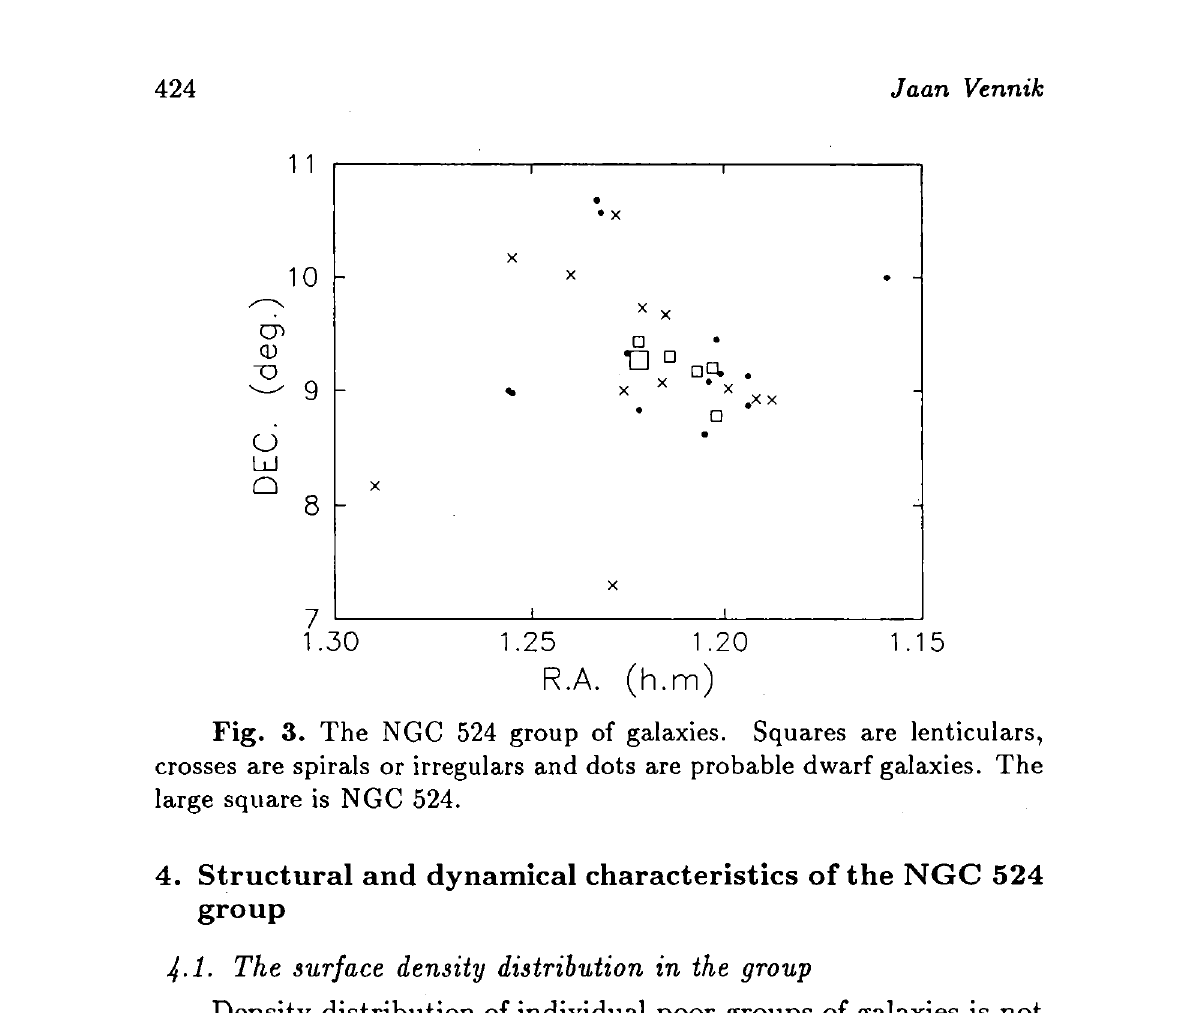
Fig. 3. The NGC 524 group of galaxies. Squares are lenticulars, crosses are spirals or irregulars and dots are probable dwarf galaxies. The large square is NGC